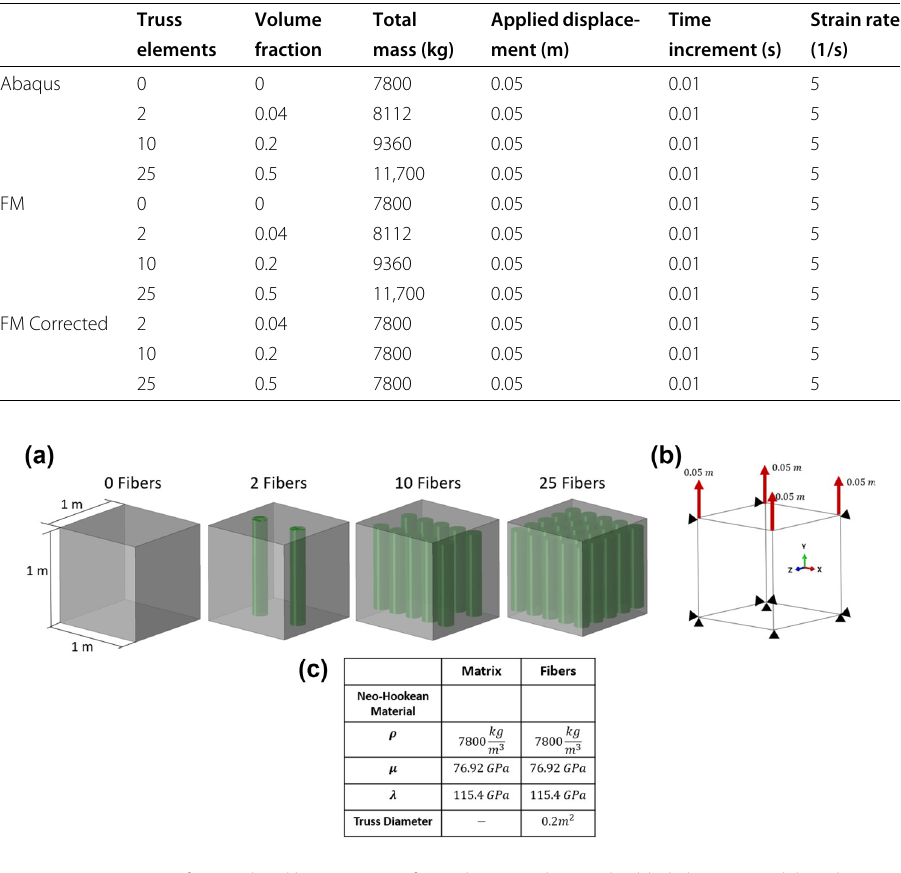
Fig. 11 Comparison of internal and kinetic energy from Abaqus and FM embedded element models with different fiber volume fractions with reference to the energy of solid element cases with no embedded elements. Increasing the fiber volume fraction increases the amount of volume redundancy and increases the error in the system. FM Corrected drastically reduces the errors in